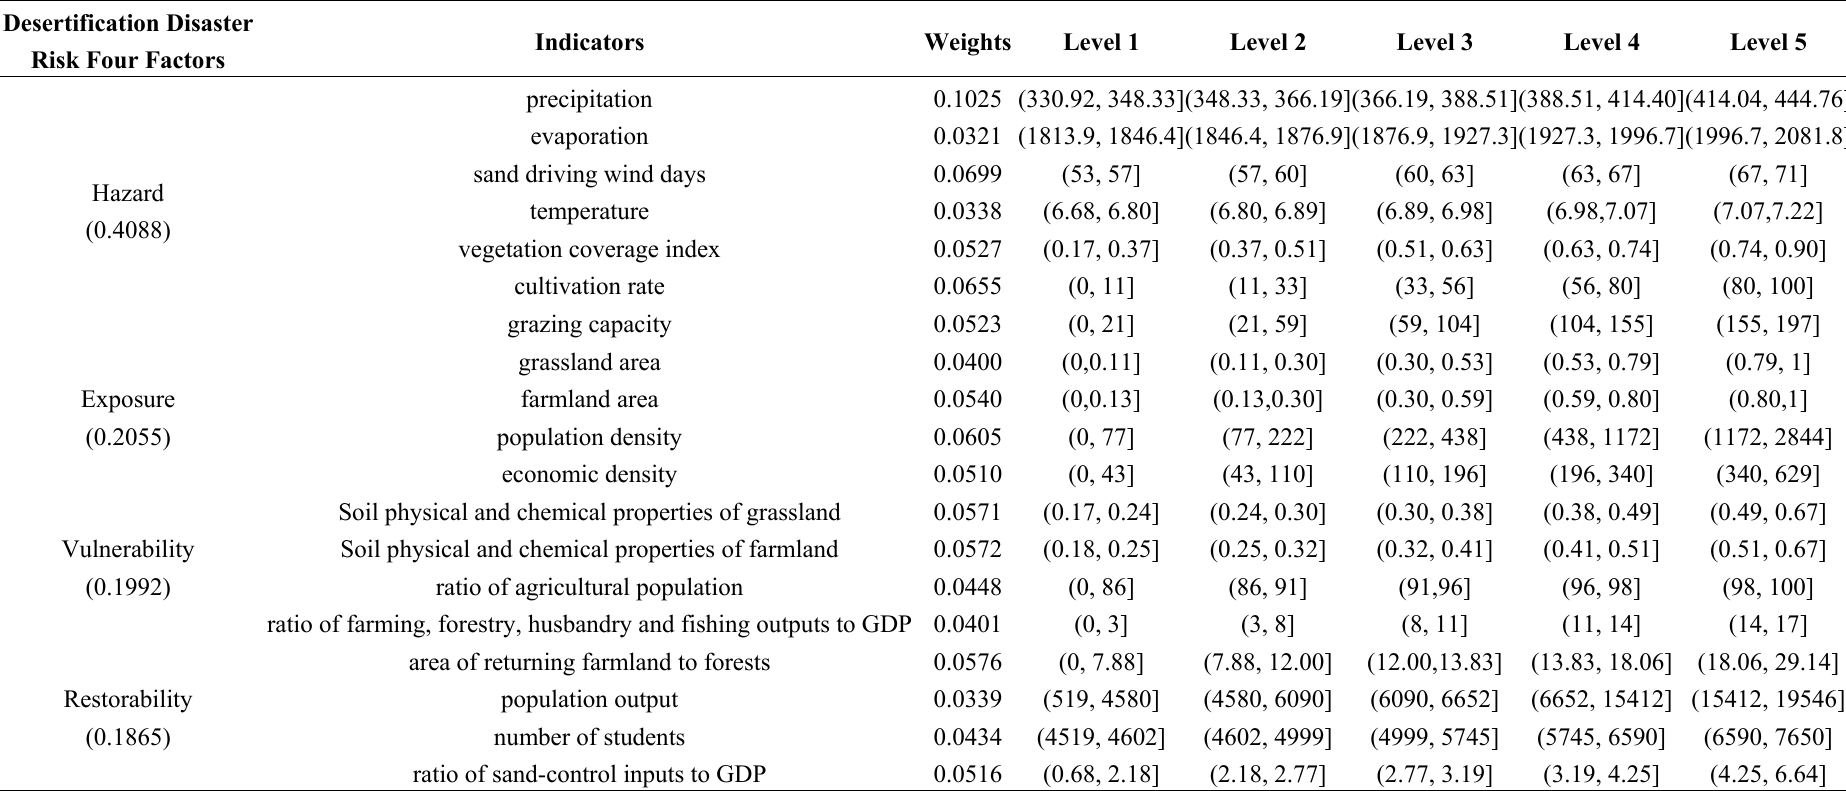
Table 2. Indicator system and its grading standard of the desertification disaster risk